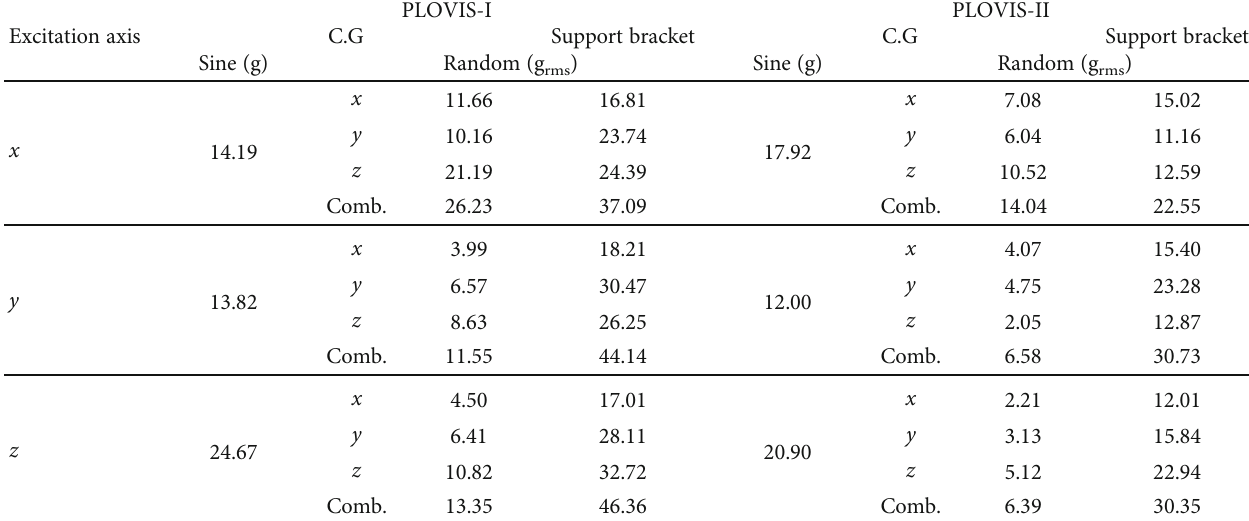
Table 4: Summary of launch vibration test results.